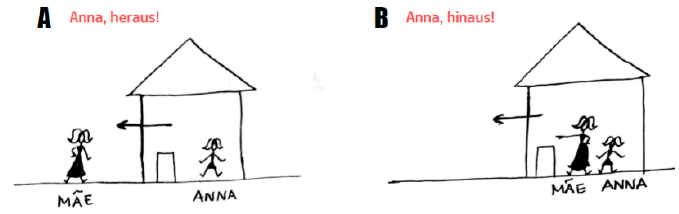
Figure 7. Example of the pictures used in Activity A of the first module.